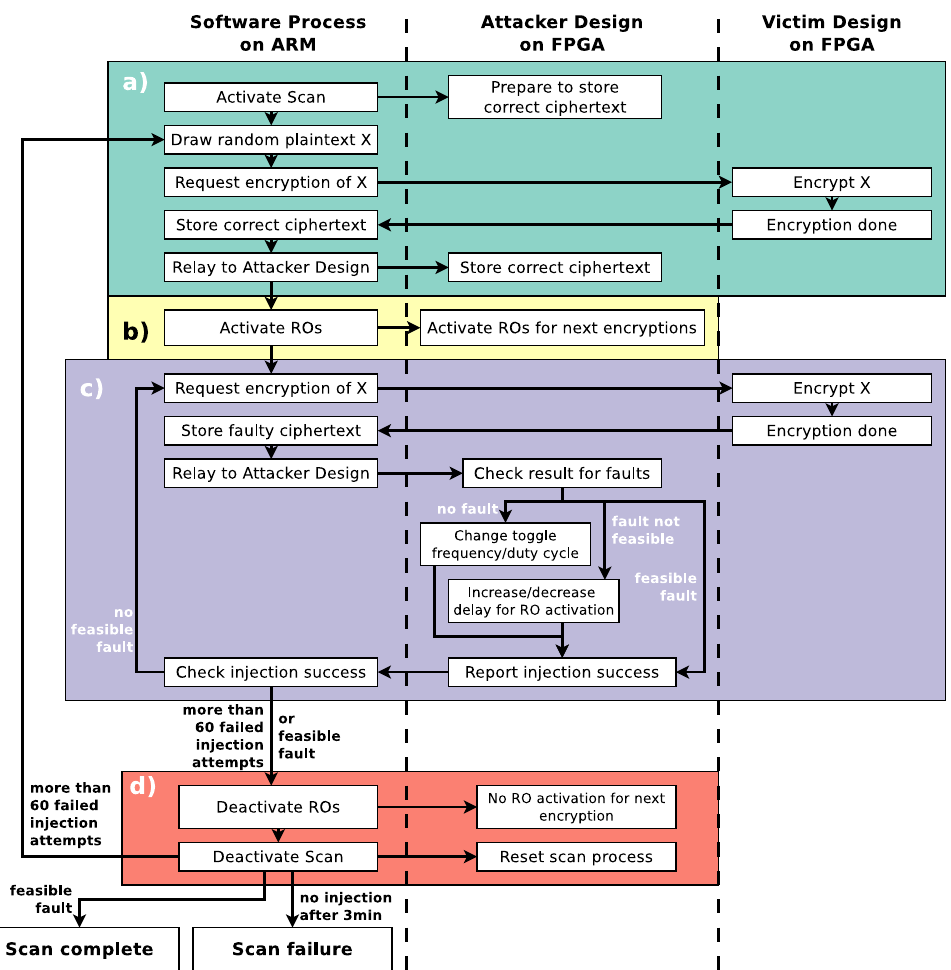
Figure 8: Flowchart of the calibration algorithm to find the appropriate parameters for injecting faults at the desired